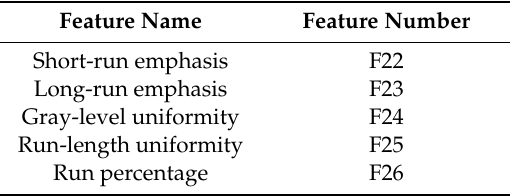
Table 5. Gray level run-length textural matrix feature sets.